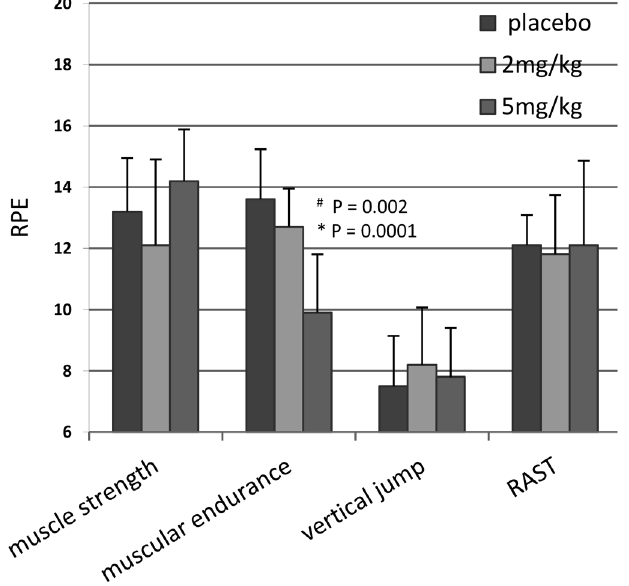
FIGURE 2 - Mean ± SD of RPE after the tests. * Significant differences (P<0.05) compared to placebo. # Significant differences (P<0.05) compared to low dose caffeine (2 mg/kg). RPE: ratings of perceived exertion; RAST: Running-based Anaerobic Sprint Test. TABLE I - The mean and standard deviation of the measured variables between different doses of caffeine and placebo